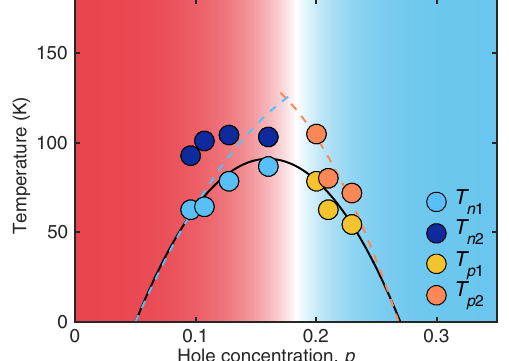
ð T Þ ¼ B þ AT α obtained C